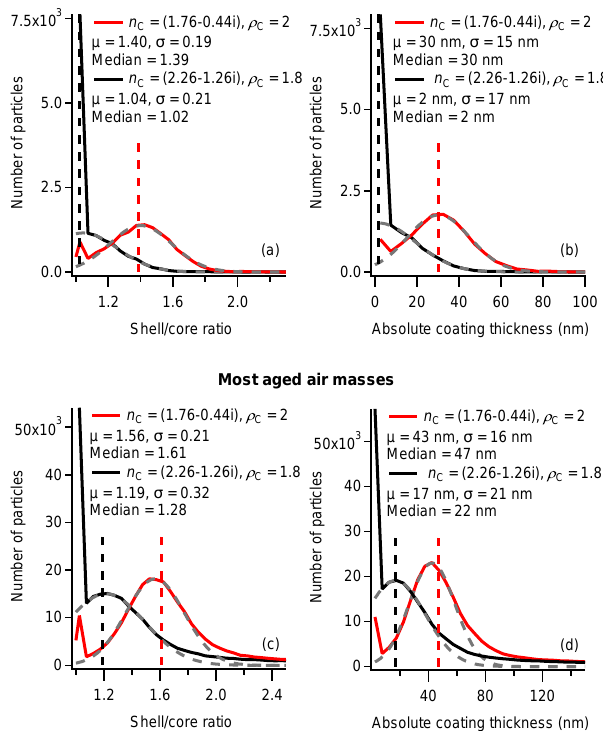
Figure 6. Distributions of (a) and (b) relative and (c) and (d) ab- solute coating thickness, measured under the same fresh and aged conditions as Fig. 3. The dashed grey lines are Gaussian fits to the primary modes, and fit parameters are listed in the legend. The first bin represents all particles with E Sca ≤ 1, and this bin was not used in the Gaussian fits. The vertical dashed lines are the median values, also listed in the legend. These are often used to compare changes in coatings and are only biased by particles with E Sca <1 if the median value falls in this